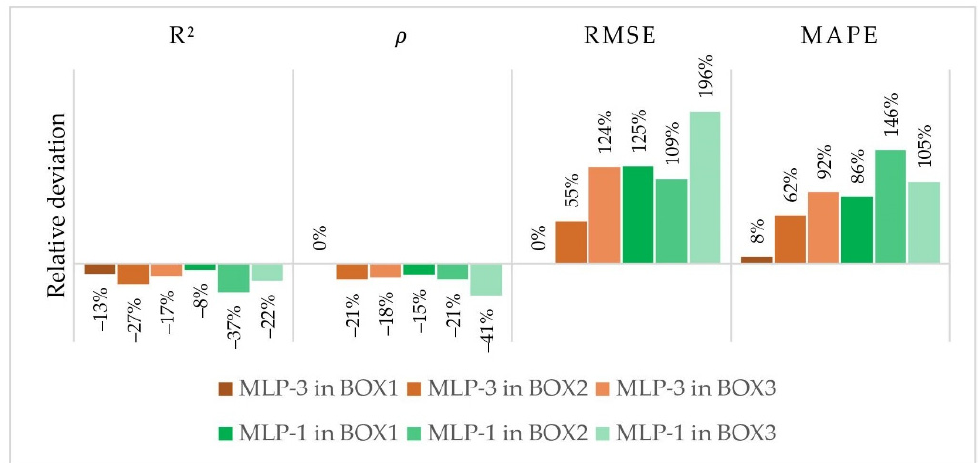
Figure 8. Relative deviation for MLP-3 (brown) and MLP-1 (green) models from the IDNN model in BOX1, BOX2, and BOX3.